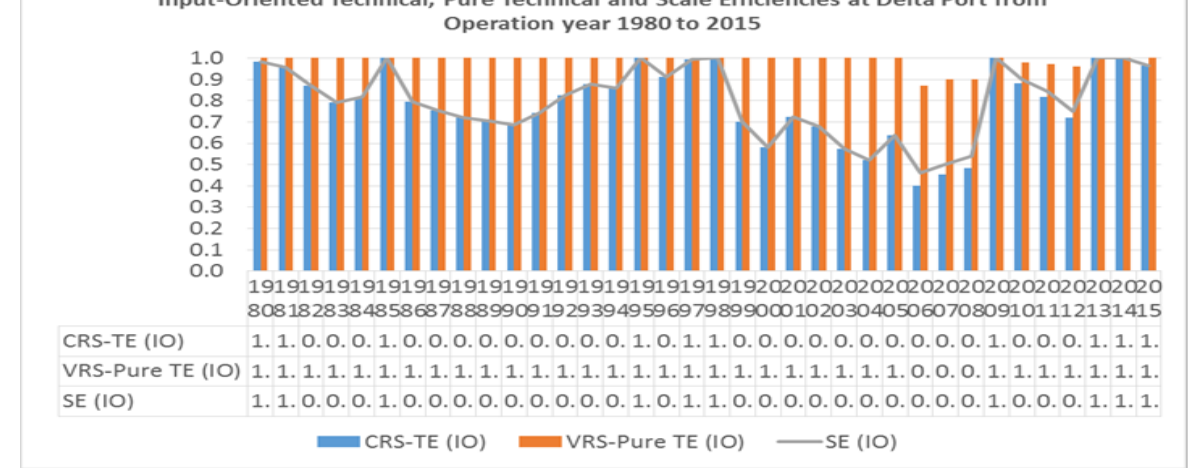
Figure 7: CRS – Technical Efficiency (Input-oriented) and CRS – Scale Efficiency (Input-oriented) at Delta Port Complex from 1980 – 2015